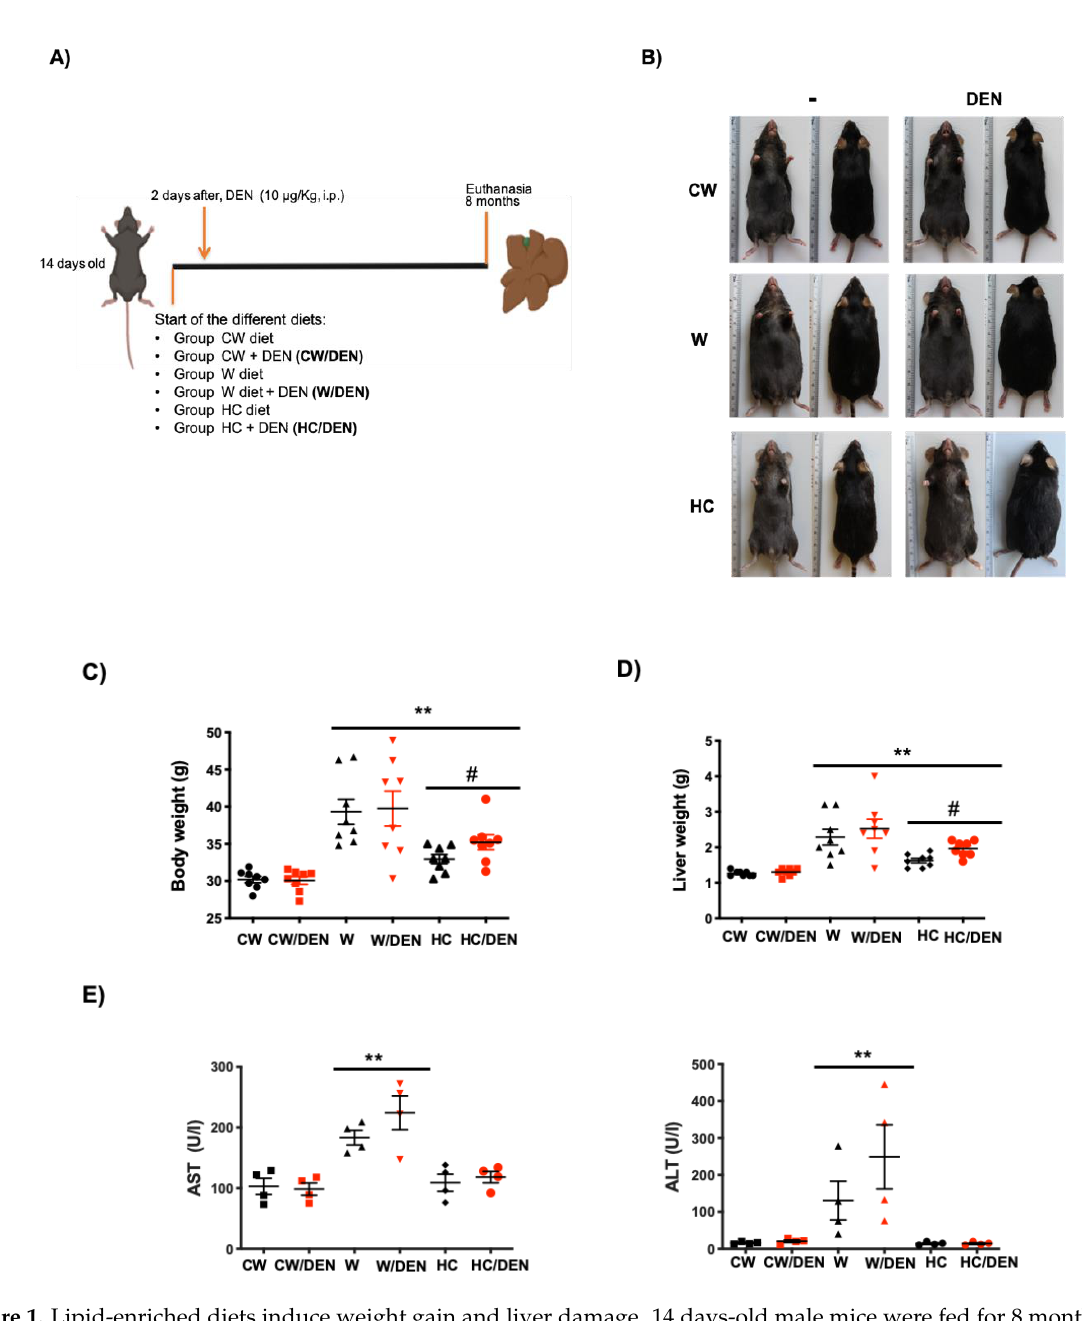
Figure 1. Lipid-enriched diets induce weight gain and liver damage. 14 days-old male mice were fed for 8 months with western and high cholesterol diets as stated in Material and Methods. ( A ) Experimental design. CW, chow standard diet; W, Western diet; HC, high cholesterol; DEN, N -nitrosodiethylamine. ( B ) Mice under the W and HC diets presented obesity. Representative images ( n = 8). ( C ) body weight ( n = 8) and, ( D ) liver weight ( n = 8), of mice under different diets. ( E ) Liver damage was addressed by serum activity of aspartate aminotransferase (AST) and alanine aminotransferase (ALT) ( n = 4). Each graph plots the individual data points, the superimpose horizontal line indicates the arithmetic mean and error bar shows ± SEM. ** p < 0.01 vs. CW groups; # p < 0.01 vs. W groups.